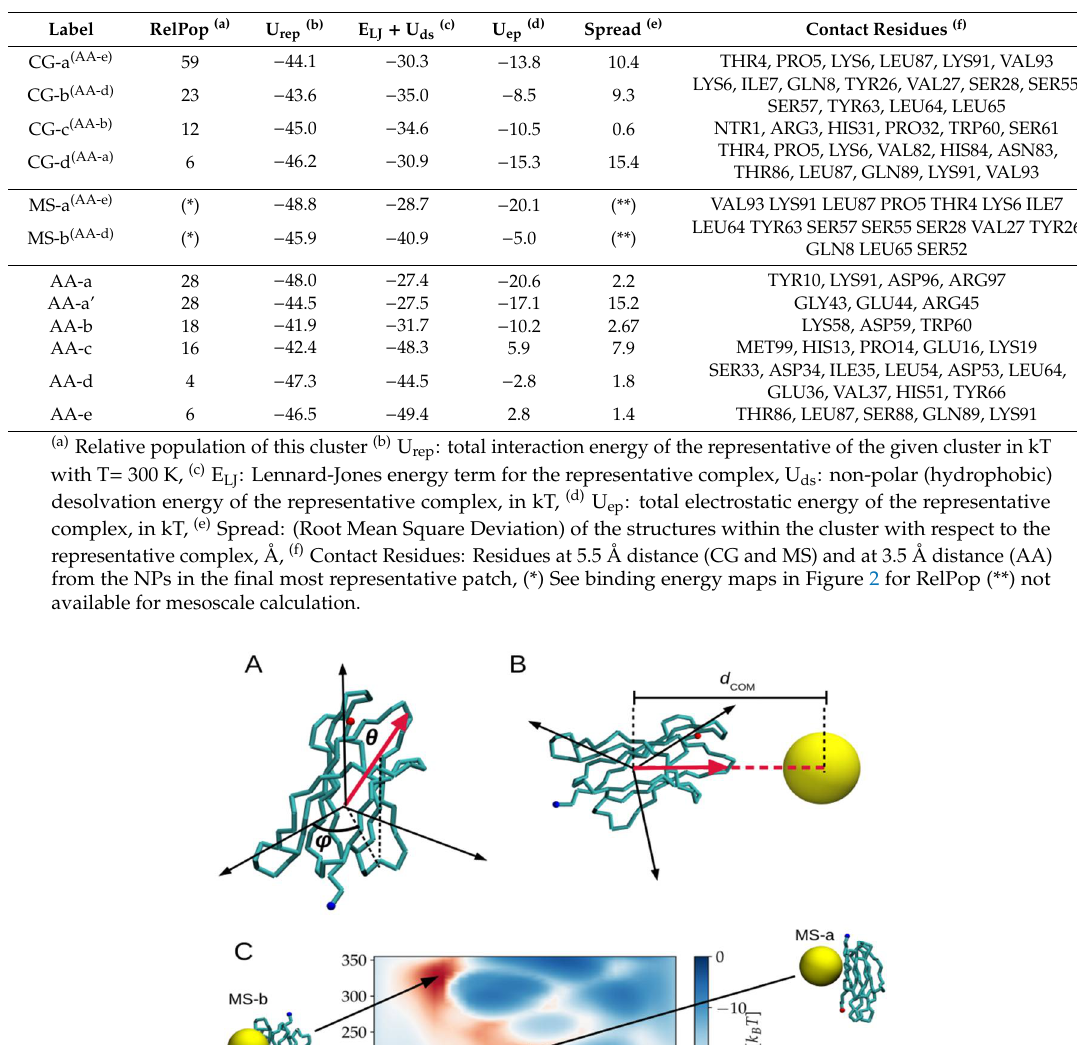
Table 1. Summary table of the results for protein-NP (nanoparticle) binding modes / energies.